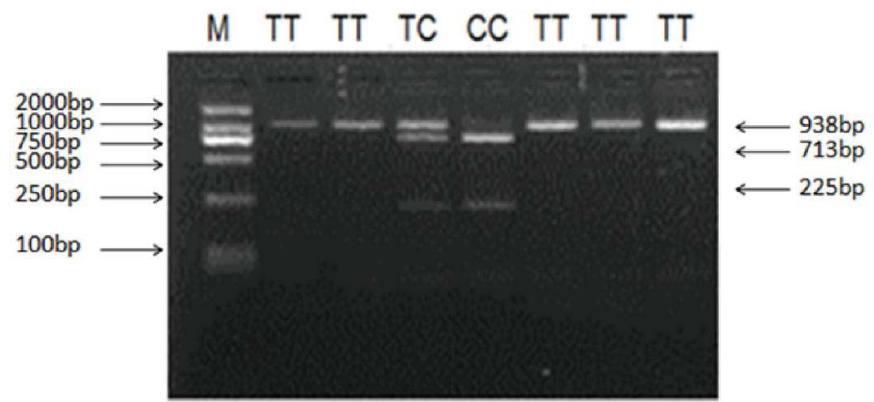
Figure 7. PCR-Restriction fragment length polymorphism (PCR-RFLP) results of different genotypes of the PCR products digested by enzyme BsrB I g.727C > T of ovine LH β polymorphisms. The genotypes are marked at the top of the lanes. M: DNA Marker (DL2000).